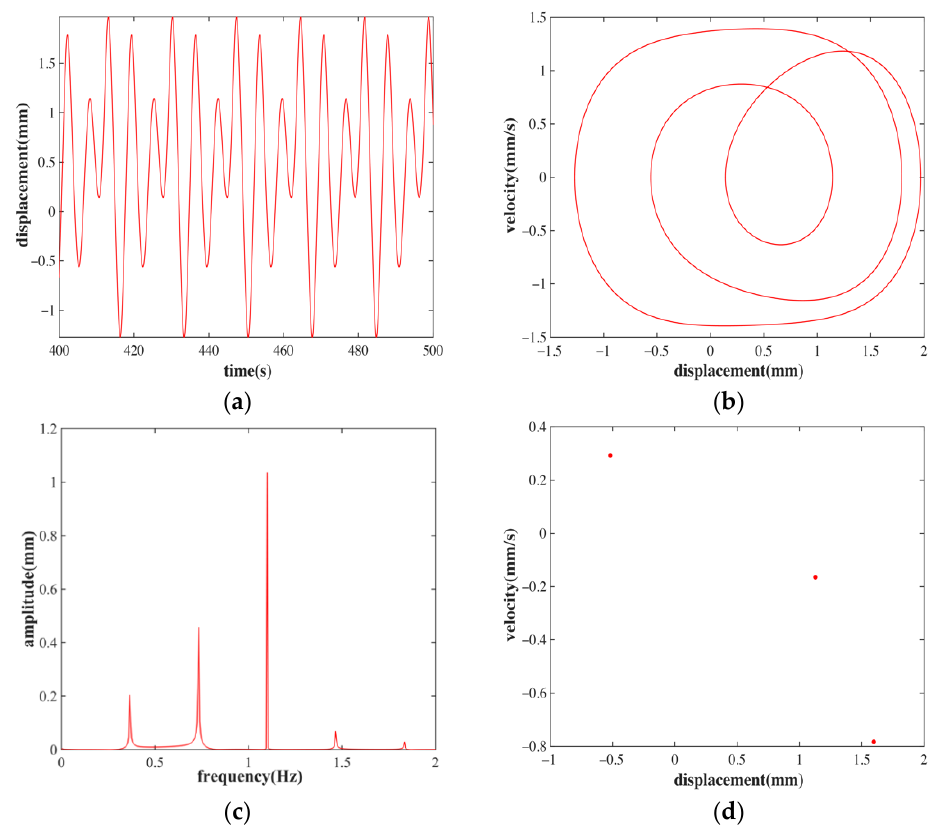
Figure 20. Nonlinear response of the GMA system at f = 1.1: ( a ) Time domain waveform diagram; ( b ) Phase trajectory curve; ( c ) Amplitude spectrum; ( d ) Poincaré diagram.